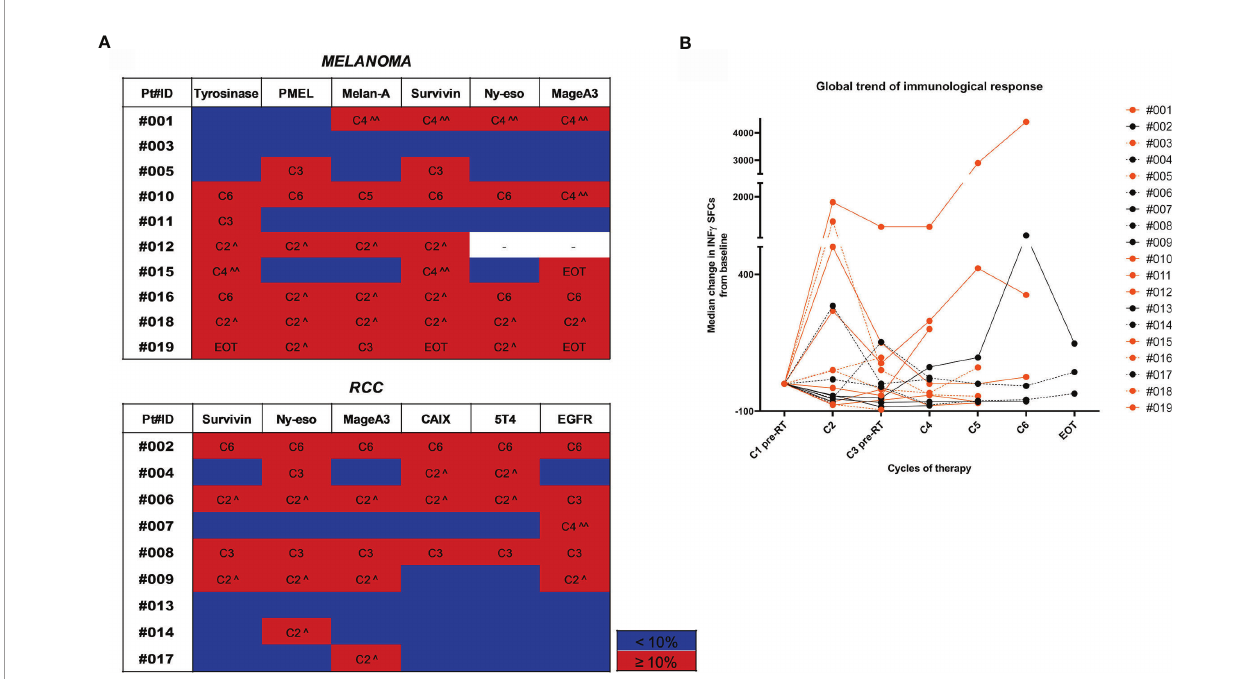
FIGURE 2 | Trend of immunological response to treatment. (A) Heatmaps highlighting the gradient of the immunological response to treatment represented as % of variation in the number of INF- g SFCs for each TAA compared to baseline values. Patients are divided by tumor type (MM upper panel and RCC lower panel). For each tested TAA, immune responses ≥ 10% compared to baseline values are highlighted in red and the therapy cycle for which the best response was observed is reported. Immune responses <10% are shown in blue. (^ after the fi rst RT cycle, ^^ after the second RT cycle). (B) The overall trend of the immunological response for each patient is shown in a spider plot (orange dots/line for MM and black dots/lines for RCC). Each dot represents the median variation in the number of INF- g SFCs for each TAA, considering the baseline value as 0. Treatment cycles are indicated in the x